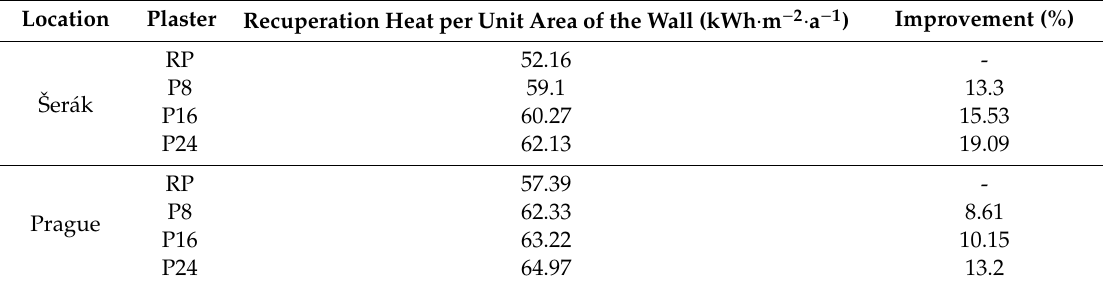
Table 5. Annual recuperation heat produced by FSPCM plaster on ceramic brick wall with mineral wool